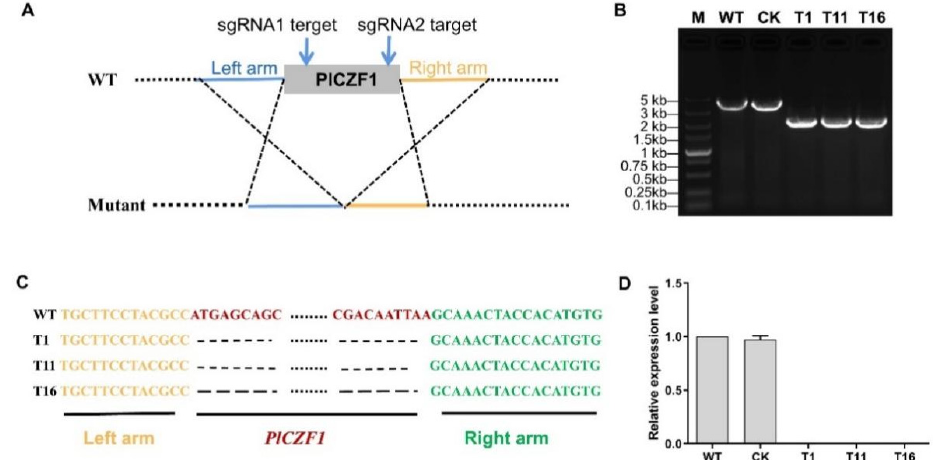
Figure 4. CRISPR/Cas9-mediated knockout of PlCZF1 . ( A ) Two single guide RNAs targeting the two sides of the PlCZF1 coding region were designed to disrupt PlCZF1 . ( B , C ) Three independent deletion mutants were identified by genomic PCR and confirmed by sequencing. ( D ) Relative expression levels of PlCZF1 were determined by qRT-PCR in WT, CK, T1, T11 and T16. The constitutive expression of PlActin was used as a reference gene. Expression levels were normalized using the WT values as ‘1’. Data represent means ± SD from three independent biological